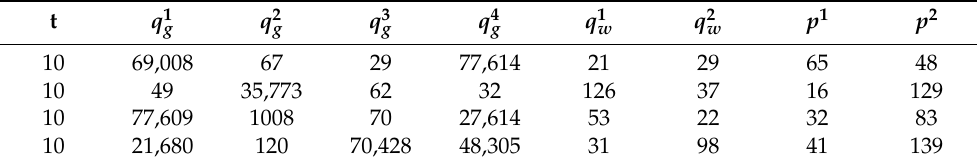
Table 2. An example of the value of injection-production parameters.